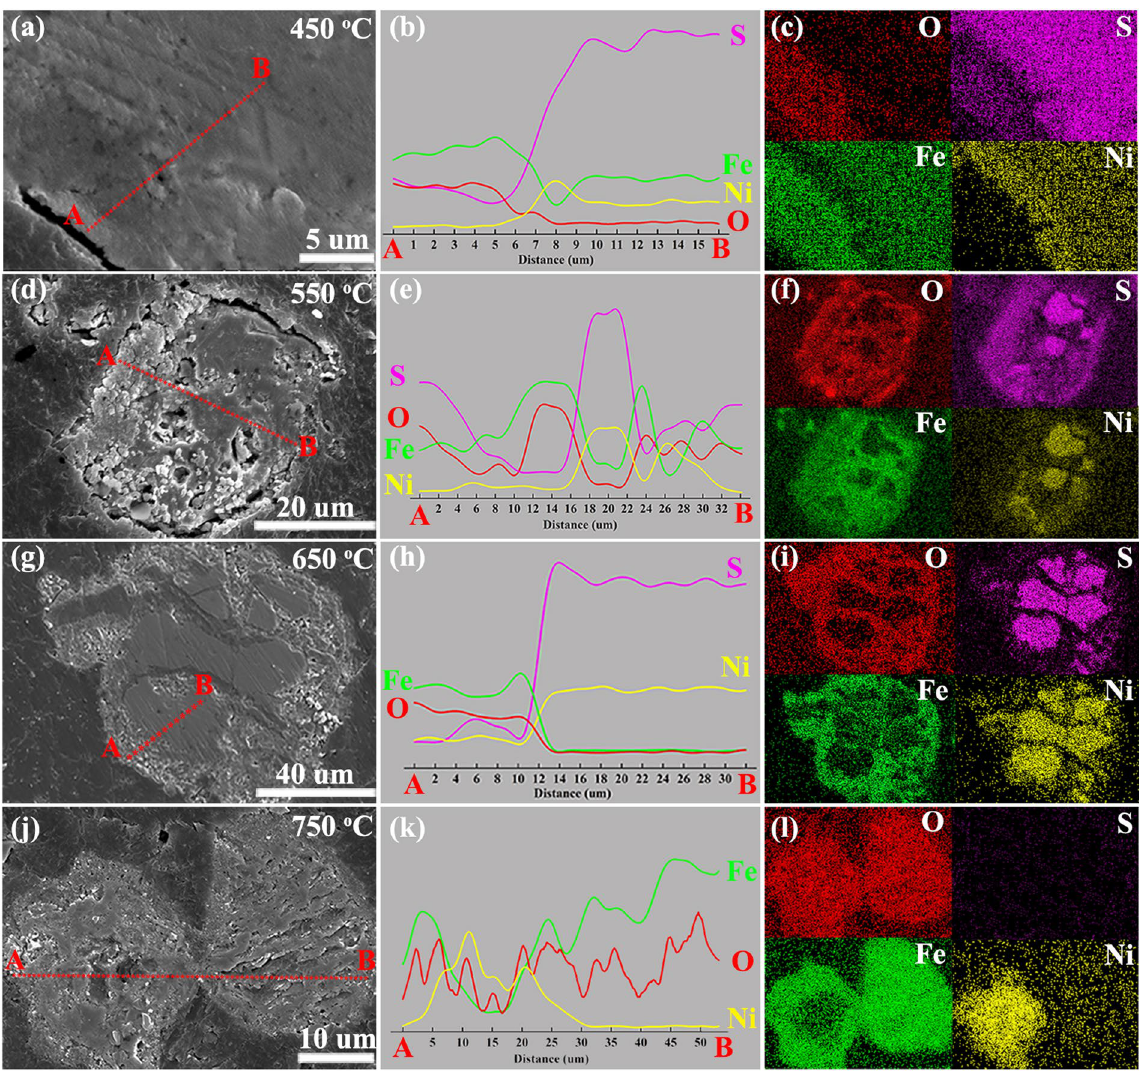
Figure 5. SEM, EDS line–scanning and EDS–mapping results for elements (O, S, Fe, and Ni) over the cross section of Pn particles after the roasting at 450 °C (a – c ), 550 °C ( d – f ), 650 °C ( g – i ), and 750 °C ( j – l ) in